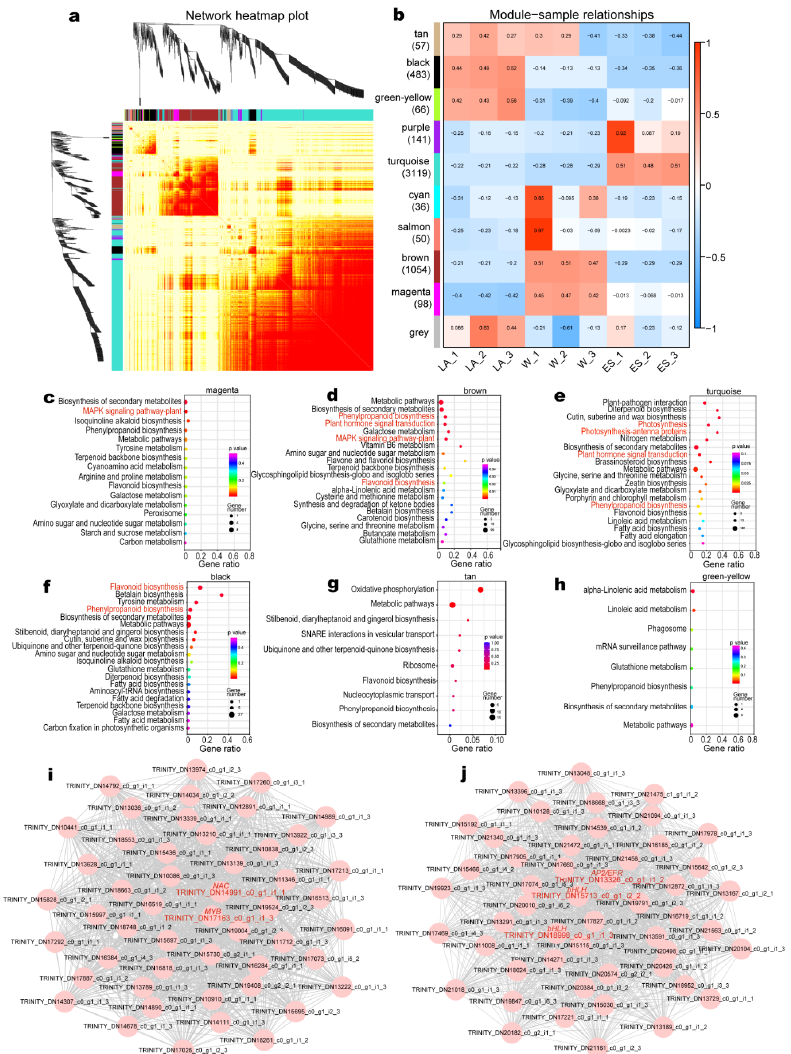
Figure 4. Construction of the DEG coexpression network and modules. ( a ) All-gene cluster heatmap. The clustering tree in the upper and left of the figure is the gene clustering tree constructed by the weighted correlation coefficient. The modules were identified by the dynamicTreeCut method. Based on a certain correlation between the gene expression levels among some modules, the corresponding modules were merged into the same module and represented by the same color. The heatmap at the bottom right is a heatmap of all gene clusters. ( b ) Module–sample relationship. The right bar represents the correlation coefficient, red/blue represents a positive/negative correlation, and numbers in the heatmap represent the correlation coefficient. Each column and each row represent each sample and module, respectively. Sample abbreviations are as follows: ES, early spring; LA, late autumn; and W, winter. LA_1, LA_2, and LA_3 represent 3 biological replicates. The text on the left is the name of each module and the number of unigenes in each module. ( c – h ) KEGG enrichment analysis of unigenes in the magenta ( c ), brown ( d ), turquoise ( e ), black ( f ), tan ( g ), and green-yellow ( h ) modules. The x - and y -axes represent the gene ratio and enriched pathways, respectively. The size of the bubble indicates the number of associated DEGs, and the color of the bubble indicates the level of significance. Pathways indicated in red text may be related to overwintering C. fortunei . ( i ) Top 50 DEGs regulatory network of C. fortunei in the brown module. ( j ) Top 50 DEGs regulatory network of C. fortunei in the turquoise module. Red text indicates hub